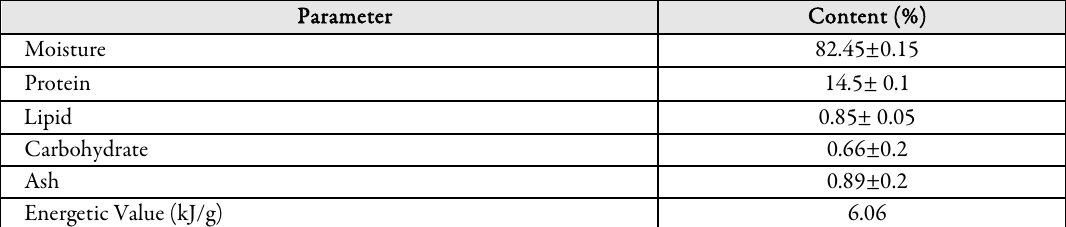
Table 1. Proximate composition of S. pharaonis (n=3)